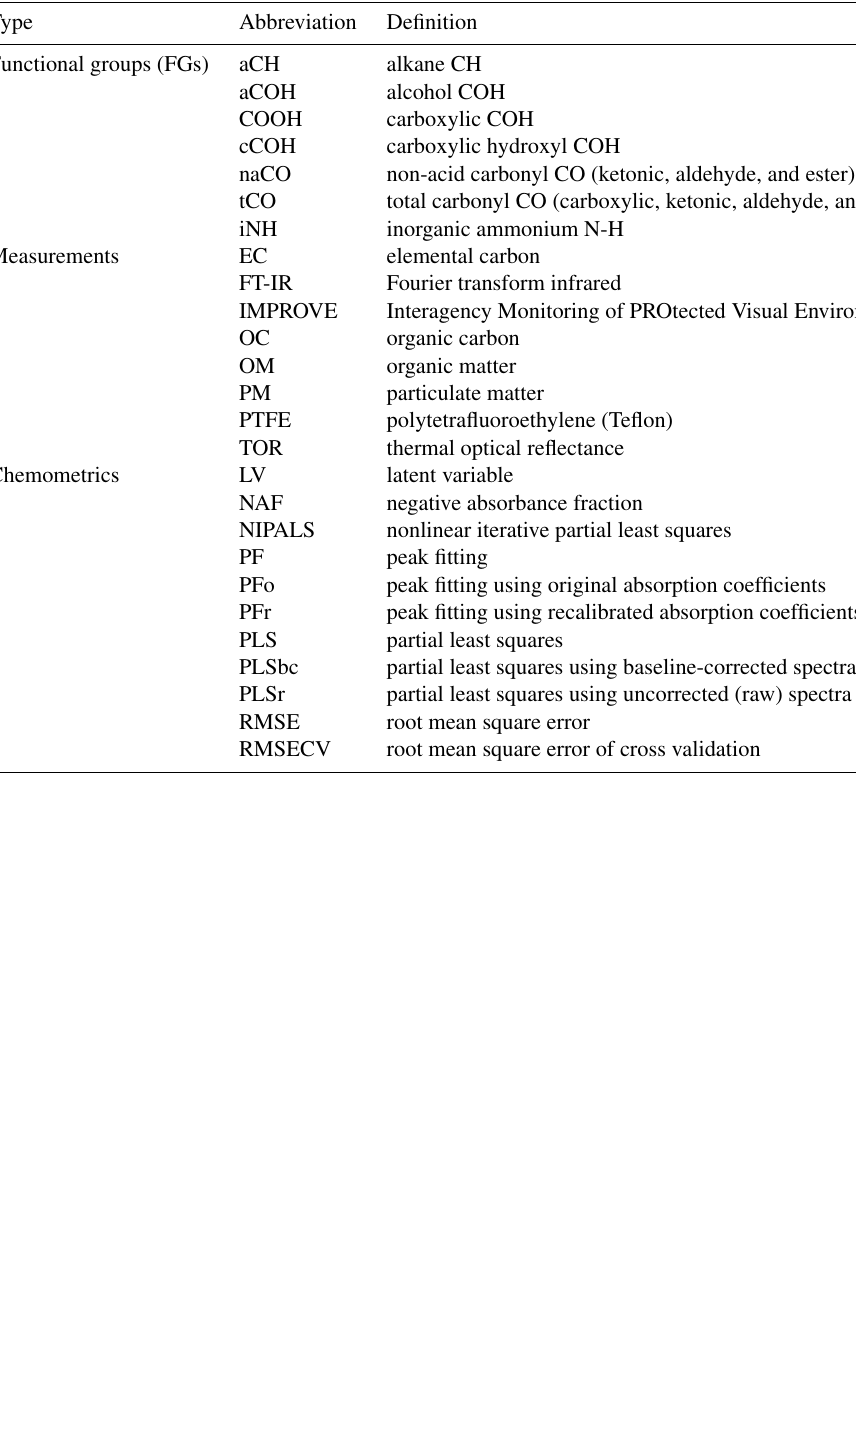
Table A1 includes pervasive abbreviations used in multiple sections. Table A1. List of abbreviations and their